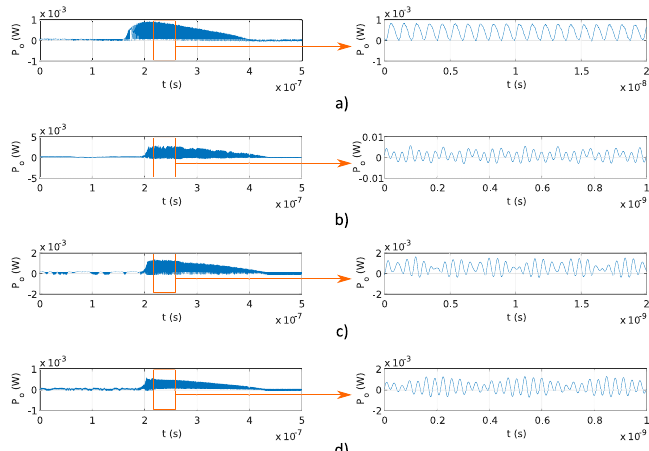
Figure 6. Pulses and fringes generated using Fabry–Perot interferometers with different OPD, reported in Table 1: ( a ) 1 GHz, ( b ) 8 GHz, ( c ) 15 GHz, and ( d ) 30